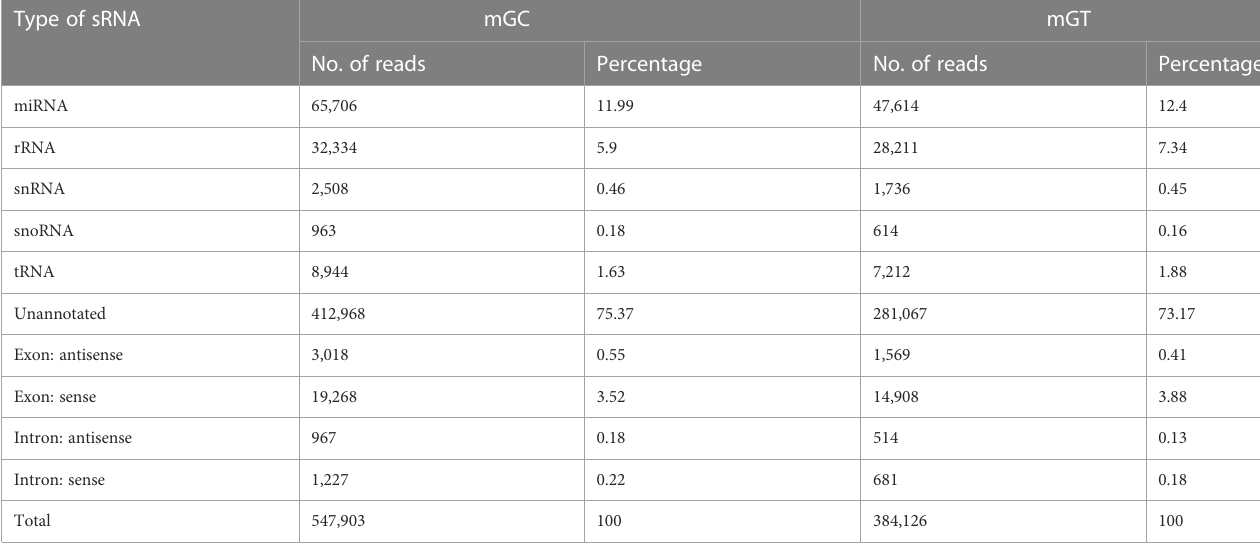
TABLE 1 Categorization of the non-coding and organellar small RNAs in the gills of Carassius auratus . Type of sRNA mGC